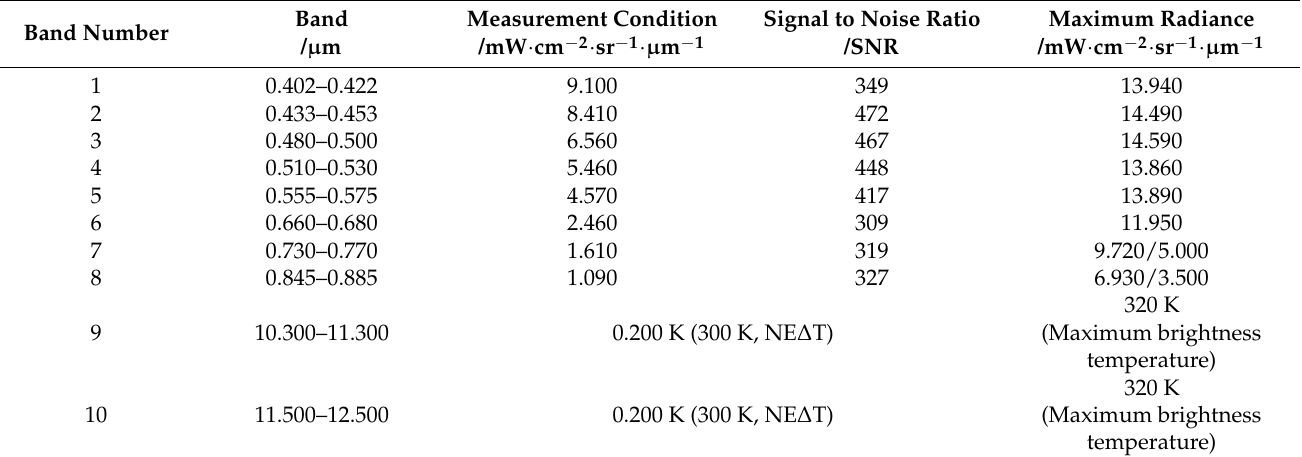
Table 1. COCTS/HY-1C band